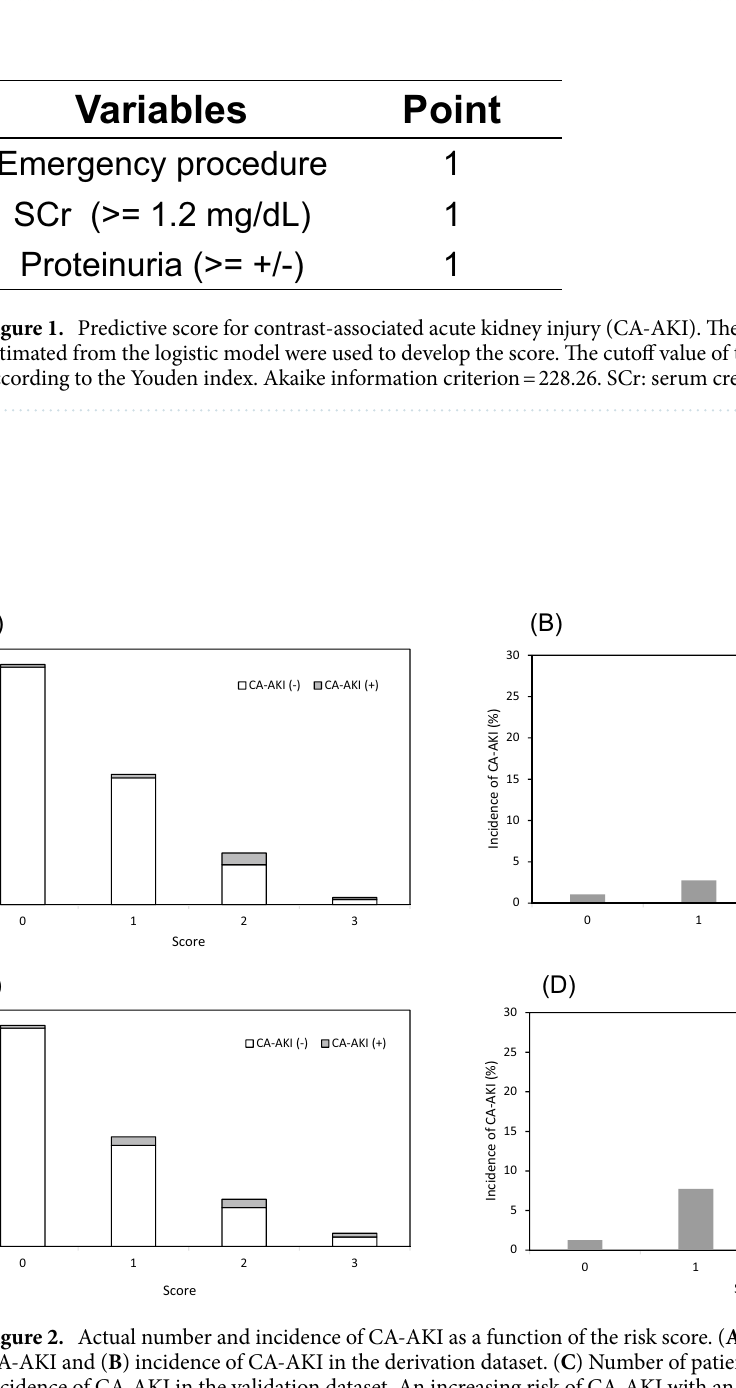
Table 2. A multivariate logistic regression analysis. The abbreviations are presented in Table 1. SE standard error, OR odds ratio, CI confidence interval. Multicollinearity diagnostics (variance inflation factor): SCr = 1.092, emergent procedure = 1.029, LVEF = 1.036, urine protein = 1.095.